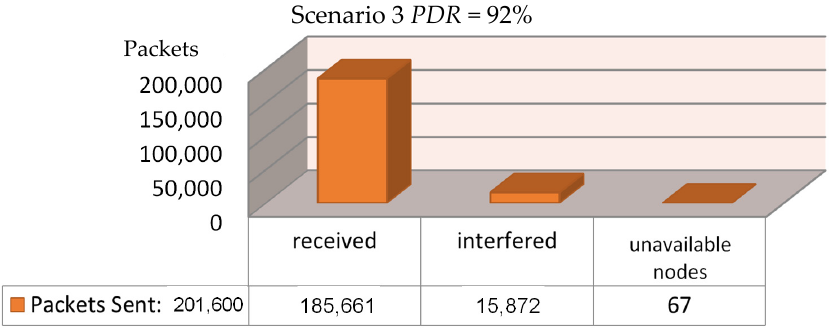
Figure 11. Scenario 3—Regarding the setup’s effectiveness once installing the gateway at the roof of a neighboring building.